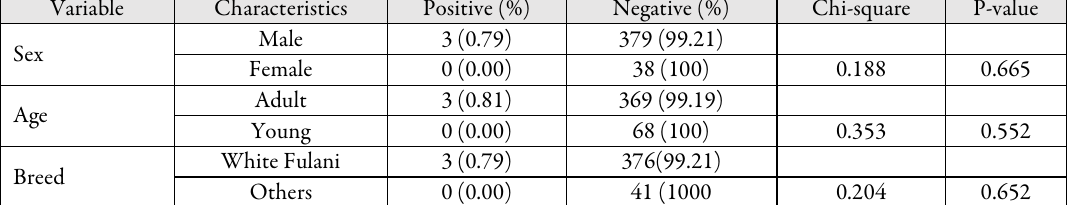
Table 2. Occurrence of tuberculous lesions in cattle slaughtered at Ikpa slaughterhouse Variable